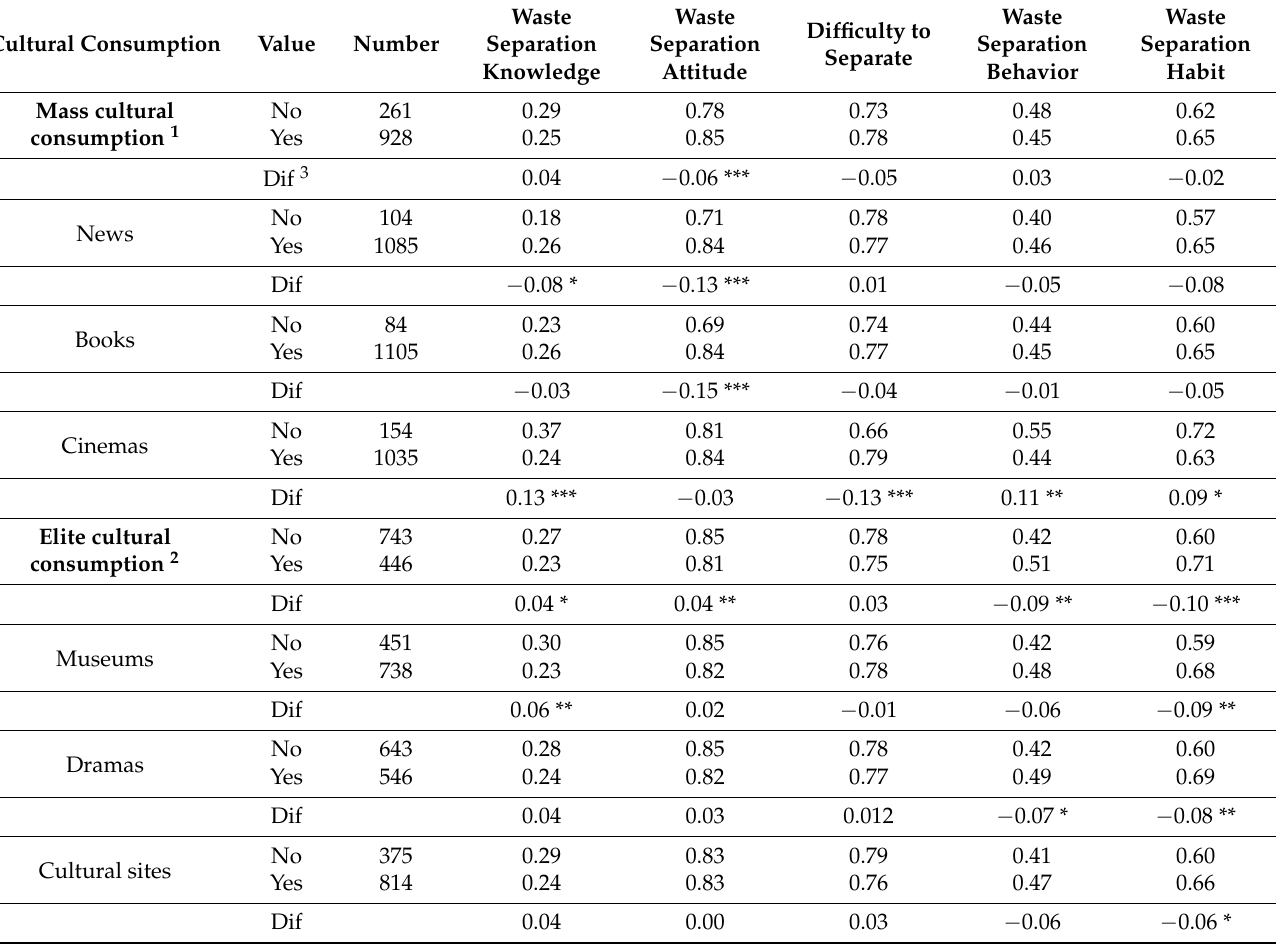
Table A3. Correlations of cultural consumption and knowledge, attitudes, and practices of waste